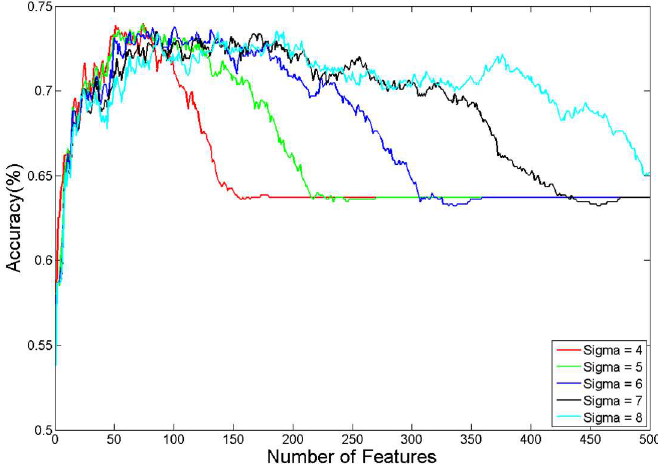
Fig 6. 5-fold cross validation accuracies on the training set. The accuraciesare obtainedusing RBF SVM (with varioussigma values), on the trainingportion of the ADHD-200dataset using functionalimages plus personalcharacteristic data. This figure is best viewedin